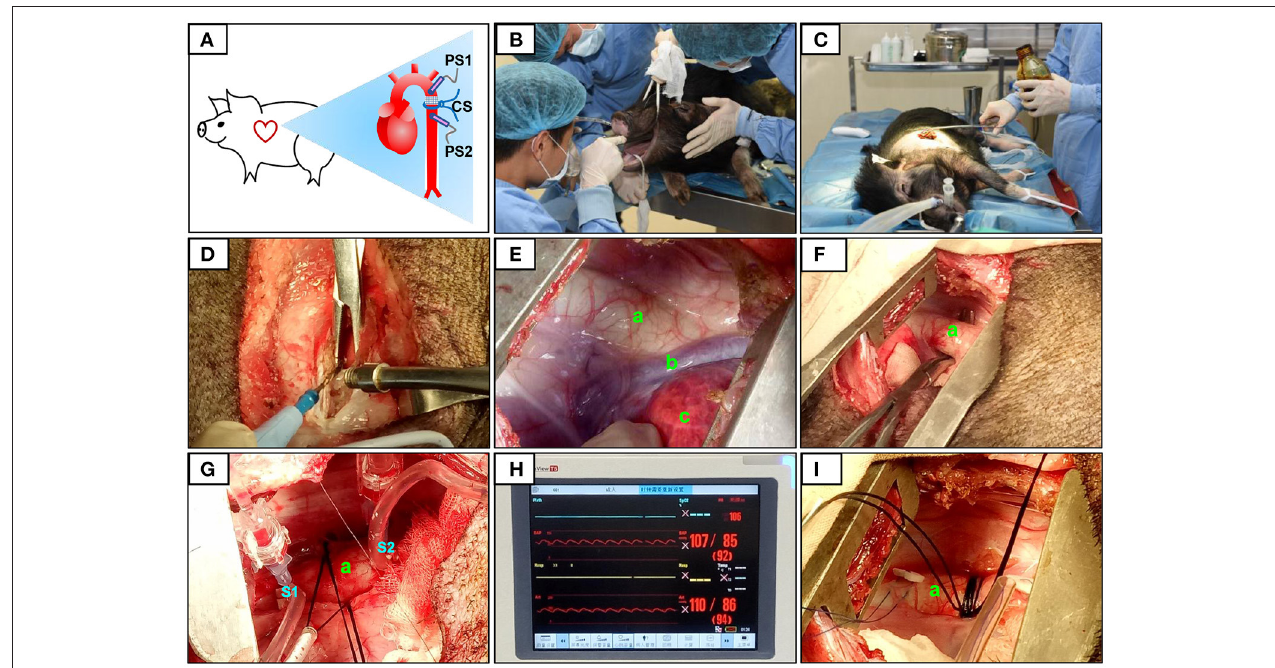
FIGURE 1 | Surgical procedure and pressure determination at the constriction site. The constriction site (CS) was at the descending aorta segment (A) . During the surgery, volatile anesthetic with isoflurane was used for the maintenance of general anesthesia (B) . After pre-operative skin preparation (C) , an incision was made and a combination of electrosurgical and blunt dissection techniques was used to separate muscle layers (D) . The descending segment of the aorta located under the fourth to fifth intercostal space was exposed (E,F) . After determining the constriction site, two pressure sensors were placed on the segment proximal to the heart (S1) and after (on the segment distal to the heart, S2) the constriction site (G) . The pressures at S1 and S2 were displayed over the ECG monitor (H) . When the pressure at S1 (PS1) reached 120% of that at S2 (PS2), the sutures were then secured with surgical knots (I) . The aorta (a), accessory hemiazygos vein (b), and lung (c) were shown in (E–G,I)